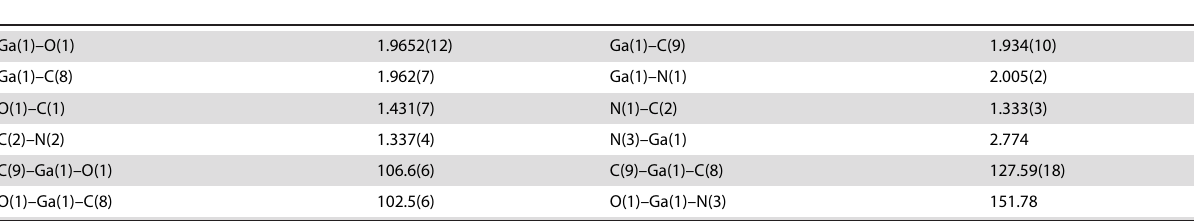
Table 5. Selected bond lengths (A˚) and angles (deg) for 4